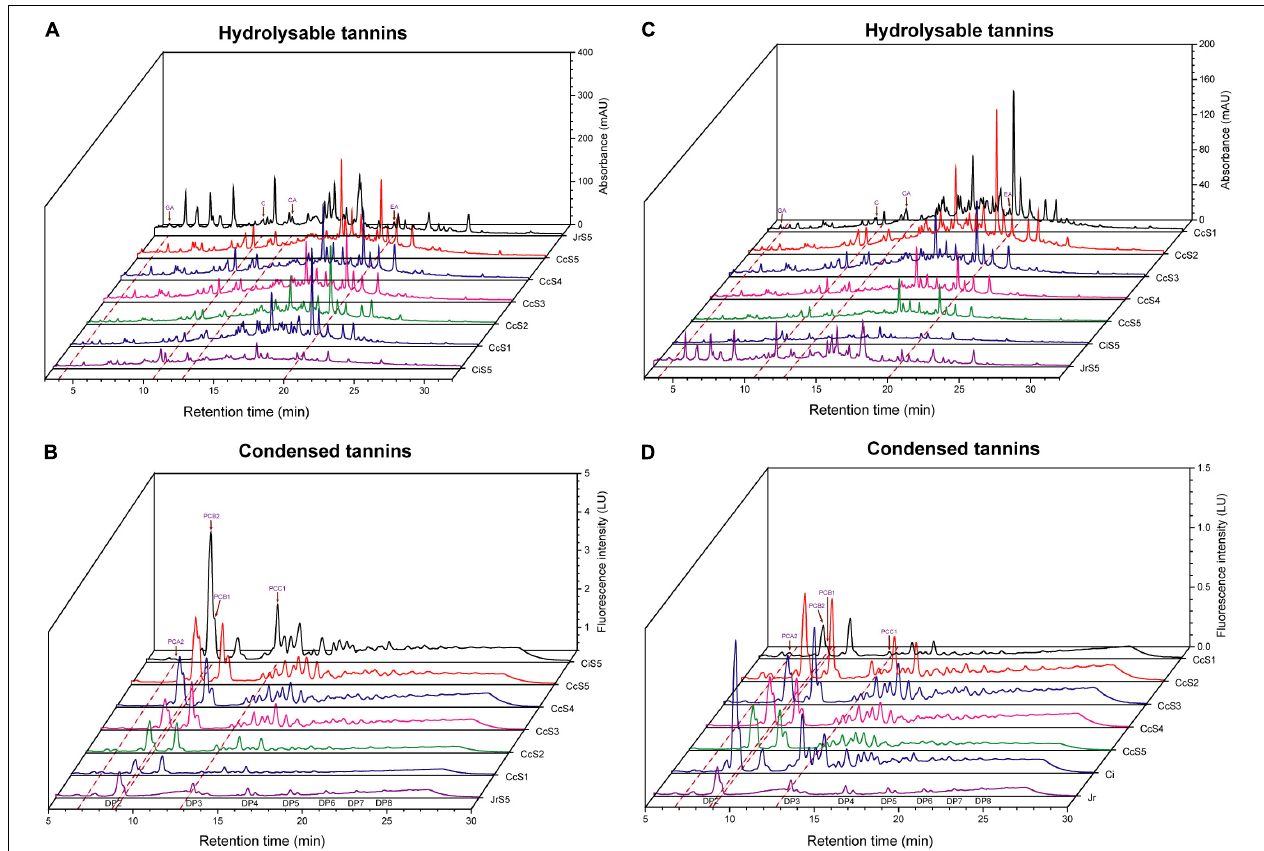
FIGURE 10 | HPLC analysis of phenolic compounds in the seed coat of maturity stage in pecan (CiS5), walnut (JrS5), and Chinese hickory (CcS1-CcS5). (A) Low-molecular-weight phenolic compounds including hydrolyzable tannins in fresh sample; (B) condensed tannins in fresh sample; (C) low-molecular-weight phenolic compounds including hydrolysable tannins in dry sample; (D) condensed tannins in dry sample. GA, gallic acid; C, catechin; CA, caffeic acid; EA, ellagic acid; PCA2, procyanidin A2; PCB2, procyanidin B2; PCB1, procyanidin B1; PCC1, procyanidin